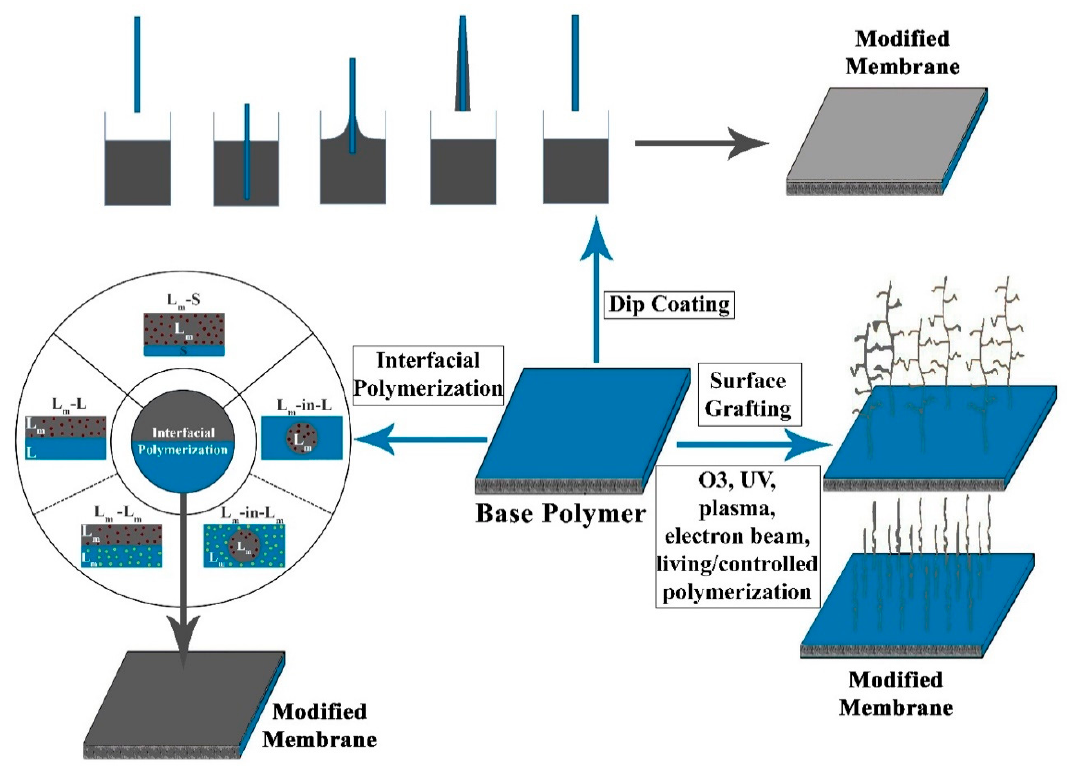
Figure 5. Methodologies for the incorporation of nanomaterials onto an MD membrane.